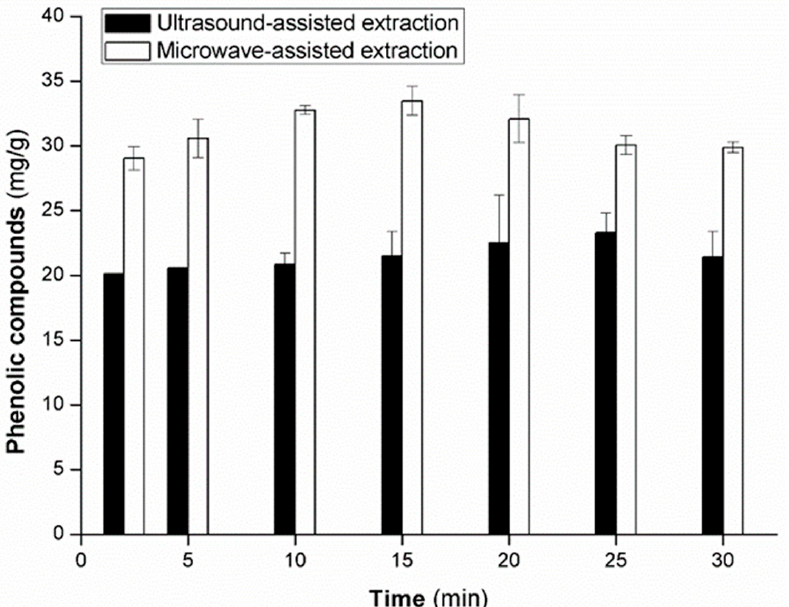
Figure 3. Total Phenolic Content (TPC) UAE and MAE from Santolina chamaecyparissus L. using different times.